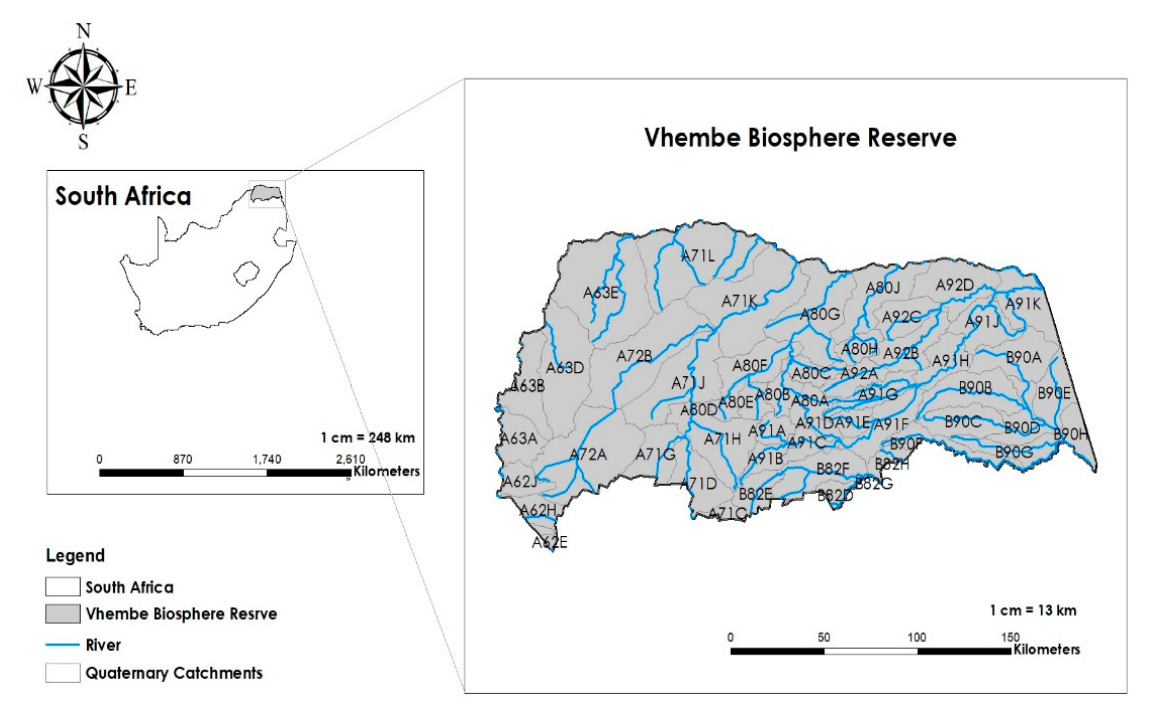
Figure 1. A map showing the spatial extent of the Vhembe Biosphere Reserve (VBR) and the catchments for potential study sites.